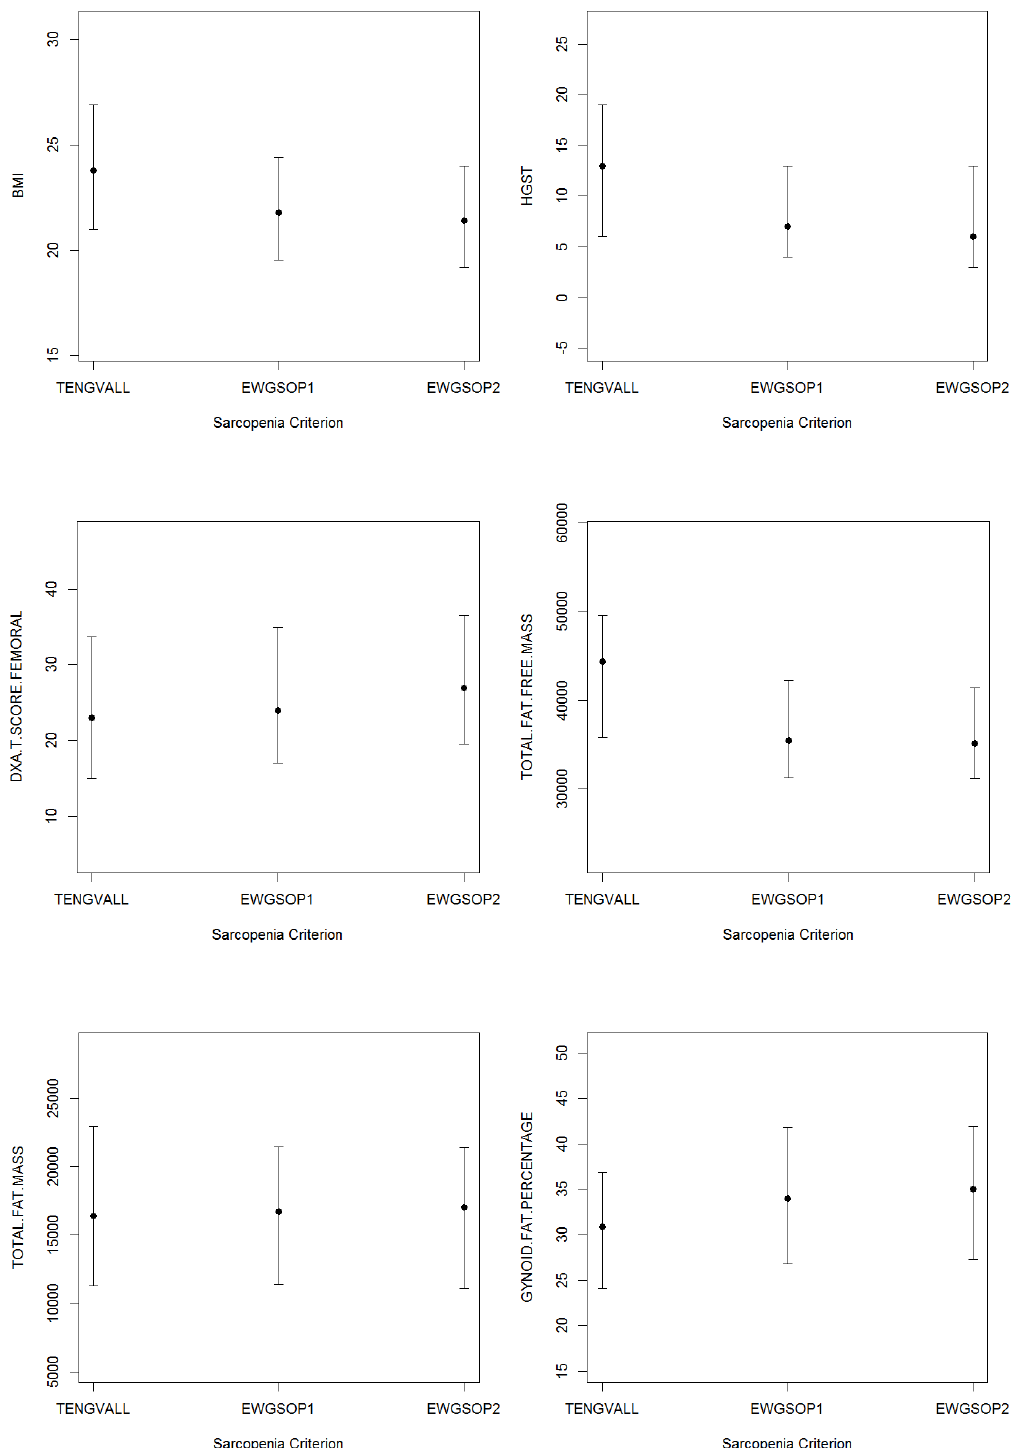
Figure A7. Summary for patients with low ASMI characteristics under each diagnostic criterion. The points represent medians, while lower and upper quartiles are represented by the vertical bars.